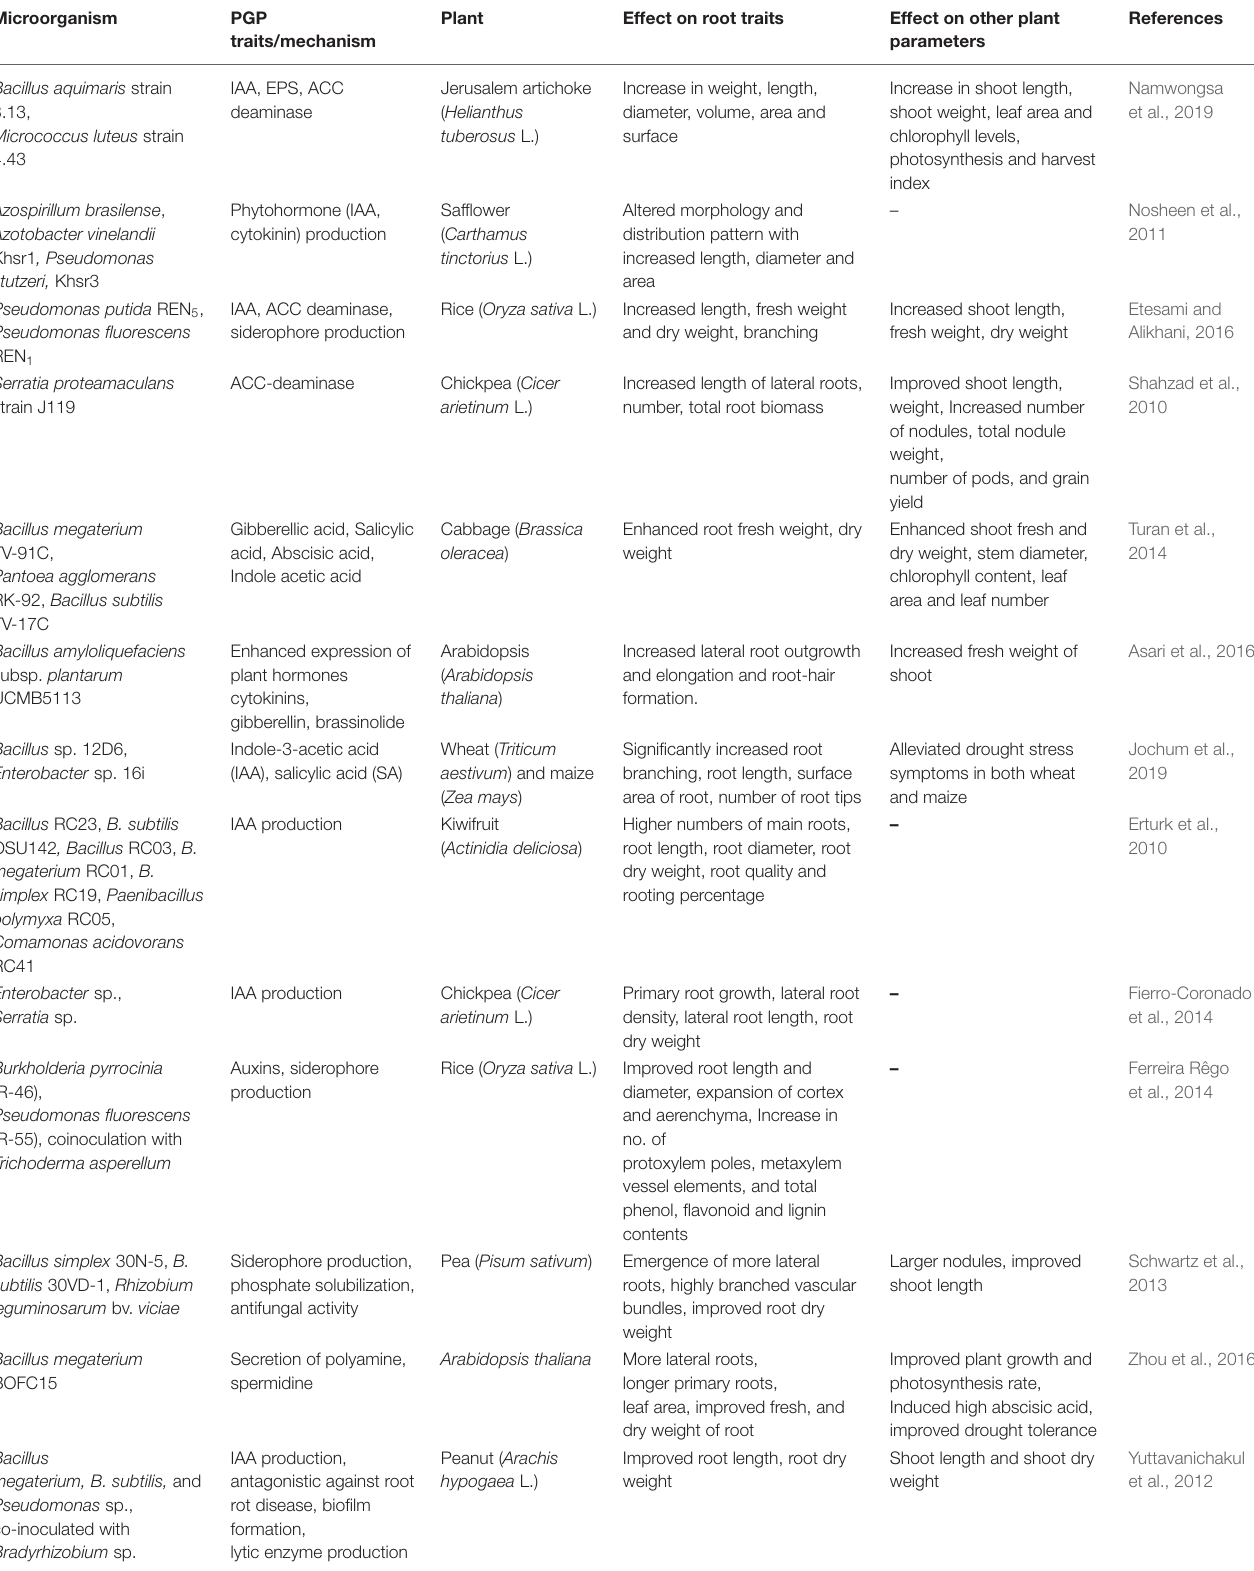
TABLE 1 | Influence of PGPR on root traits and other growth parameters of inoculated